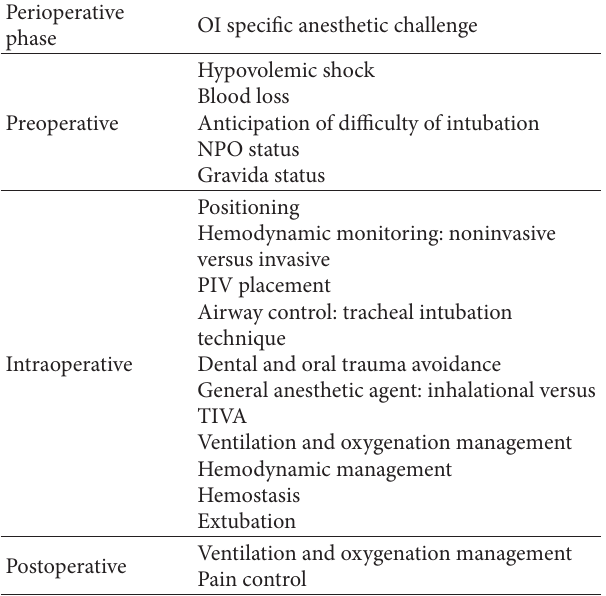
Table 2: Osteogenesis imperfecta challenges in the perioperative